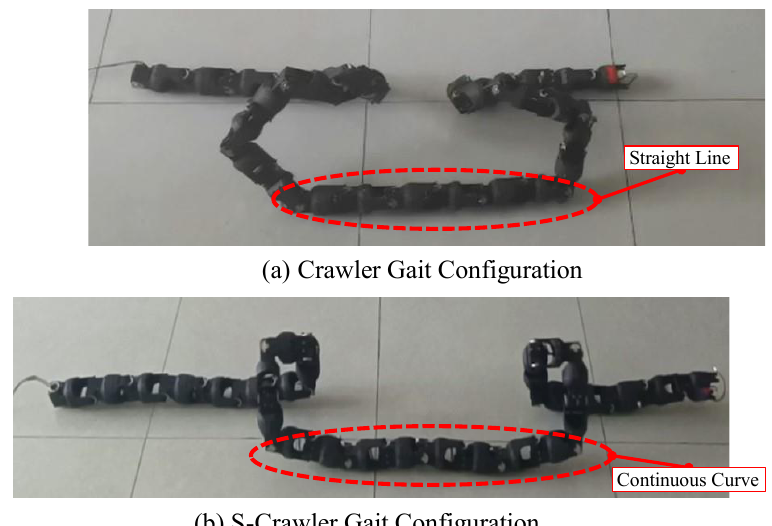
Figure 5. Realization of snake robot with s-crawler gait. The crawler gait configuration and S-crawler gait configuration of the serpentine robot are shown in ( a , b ), respectively. The most obvious difference between them is that the straight segment of the original configuration changes into a continuous curve